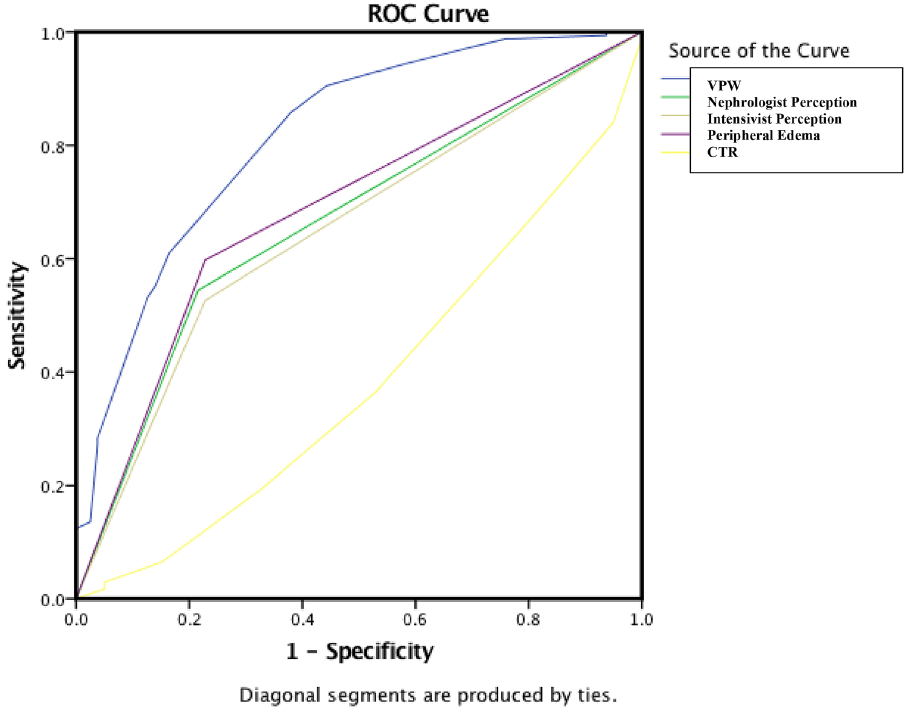
Figure 1. ROC curves of the VPW, clinician judgment, peripheral edema and CTR to predict the absence of hypotension during